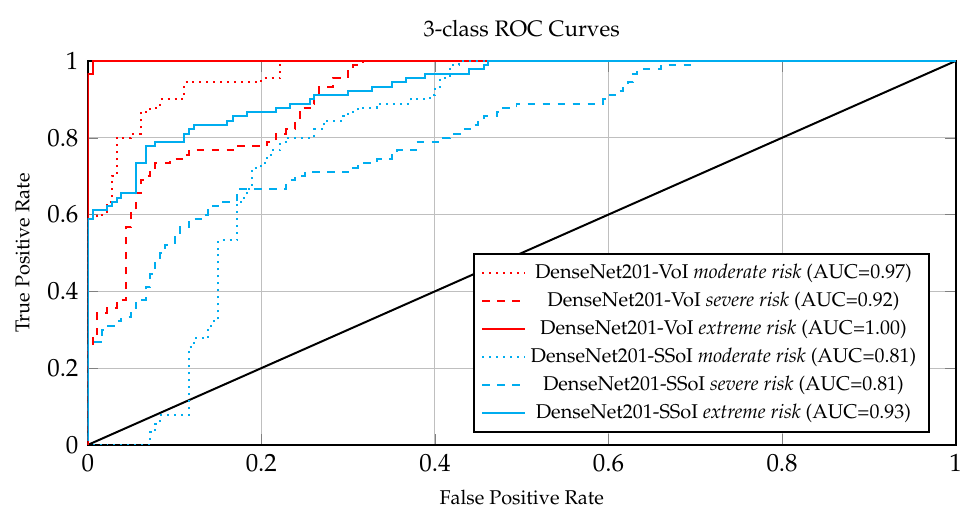
Figure 6. Receiver operating curve (ROC) of DenseNet201-VoI and DenseNet201-SSoI models on COVID-19_CHDSET US with one ROC curve plotted for each